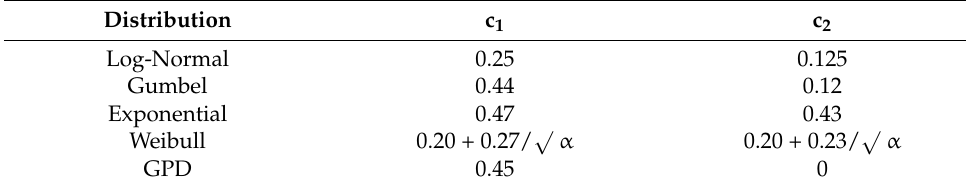
Table 1. Constants of unbiased position plotting. Distribution c